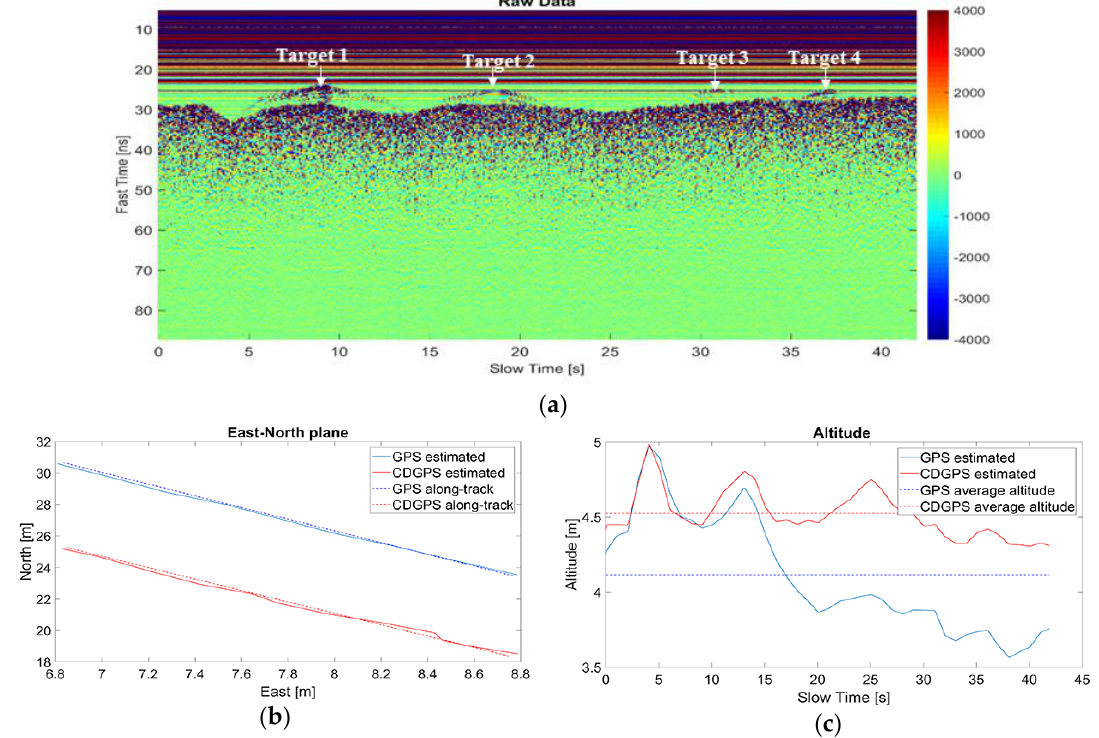
Figure 14. Test 2-Track 1: ( a ) raw data; ( b ) east–north UAV positions estimated by GPS (solid blue line) and CDGPS (solid red line), along-track direction defined by GPS (dashed blue line) and CDGPS (dashed red line); ( c ) UAV Altitude estimated by GPS (solid blue line) and CDGPS (solid red line), average altitude defined by GPS (dashed blue line) and CDGPS (dashed red